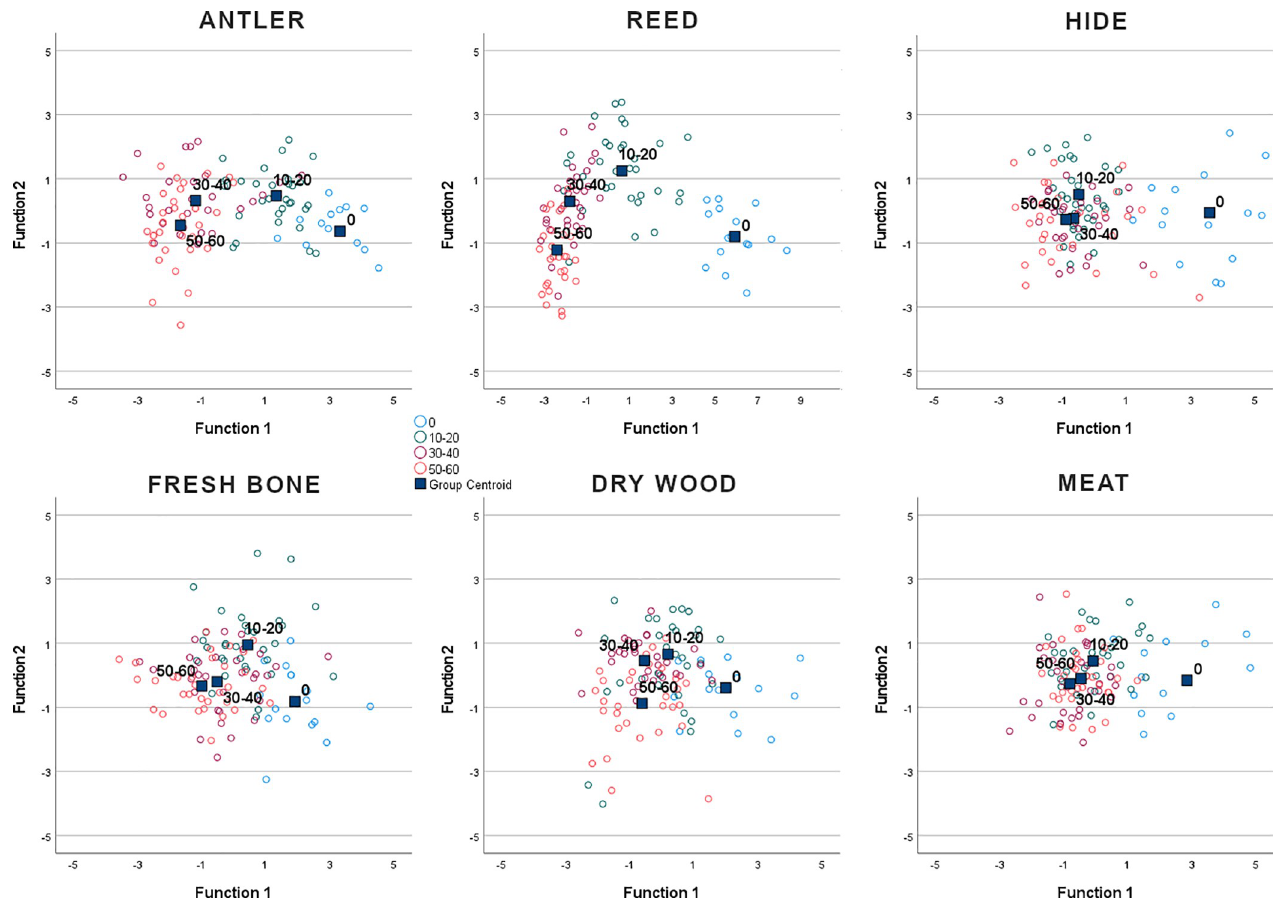
Fig 7. Quadratic discriminant analysis of antler, reed, hide, bone wood and meat polish at 0, 10, 20, 30, 40, 50 and 60 minutes.